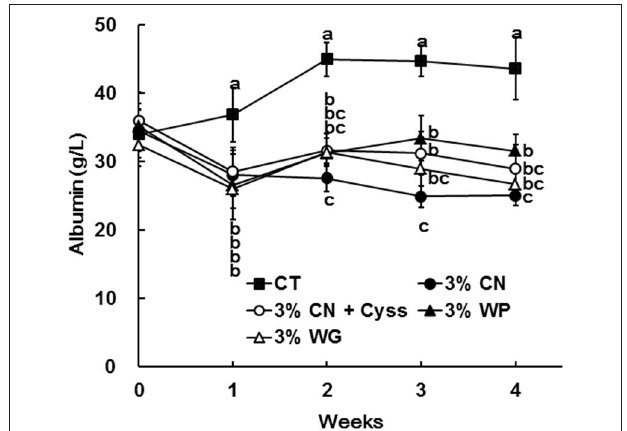
FIGURE 1 | Plasma albumin levels in Experiment 1. The levels of albumin were measured for plasma samples obtained during the experimental period. Data are shown as means ± SD ( n = 6); values with different letters are significantly different at each time point ( P < 0.05). CN, CT, Cyss, WG, and WP denote casein, control, cystine, wheat gluten, and whey protein, respectively.